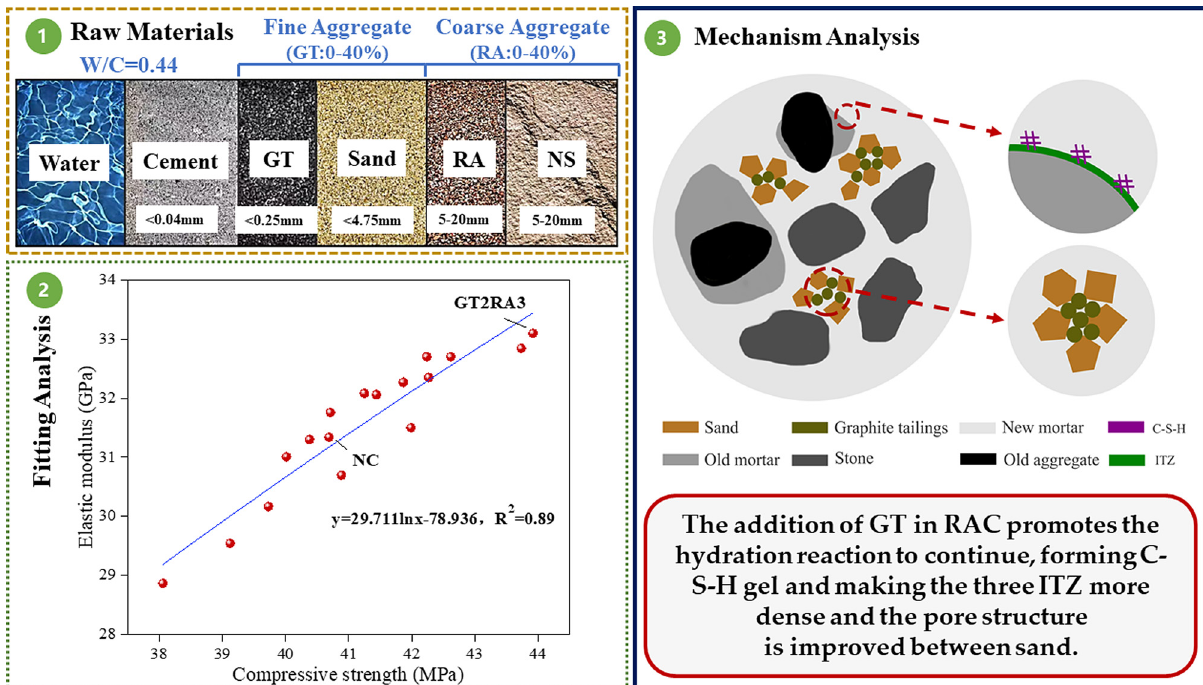
Figure 19: E ff ect mechanism diagram of GTRAC.